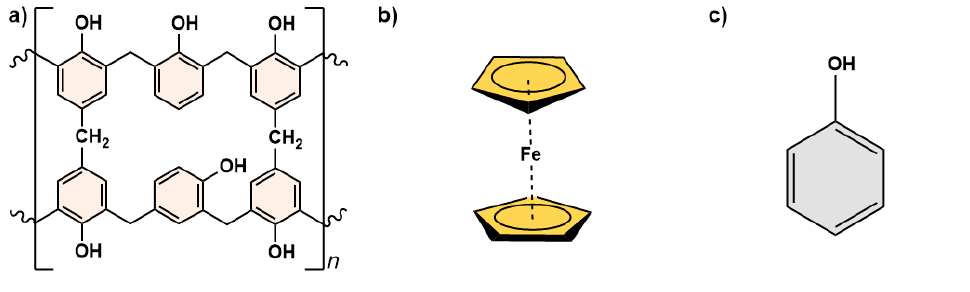
Figure 1. Chemical structures of the starting materials used in the FPOPs syntheses: ( a ) Bakelite skeleton, ( b ) ferrocene (Fc) structure and ( c ) phenol (Ph). For reference, the approximate Bakelite molecular formula is (C 44 H 36 O 6 ) n [5–7].